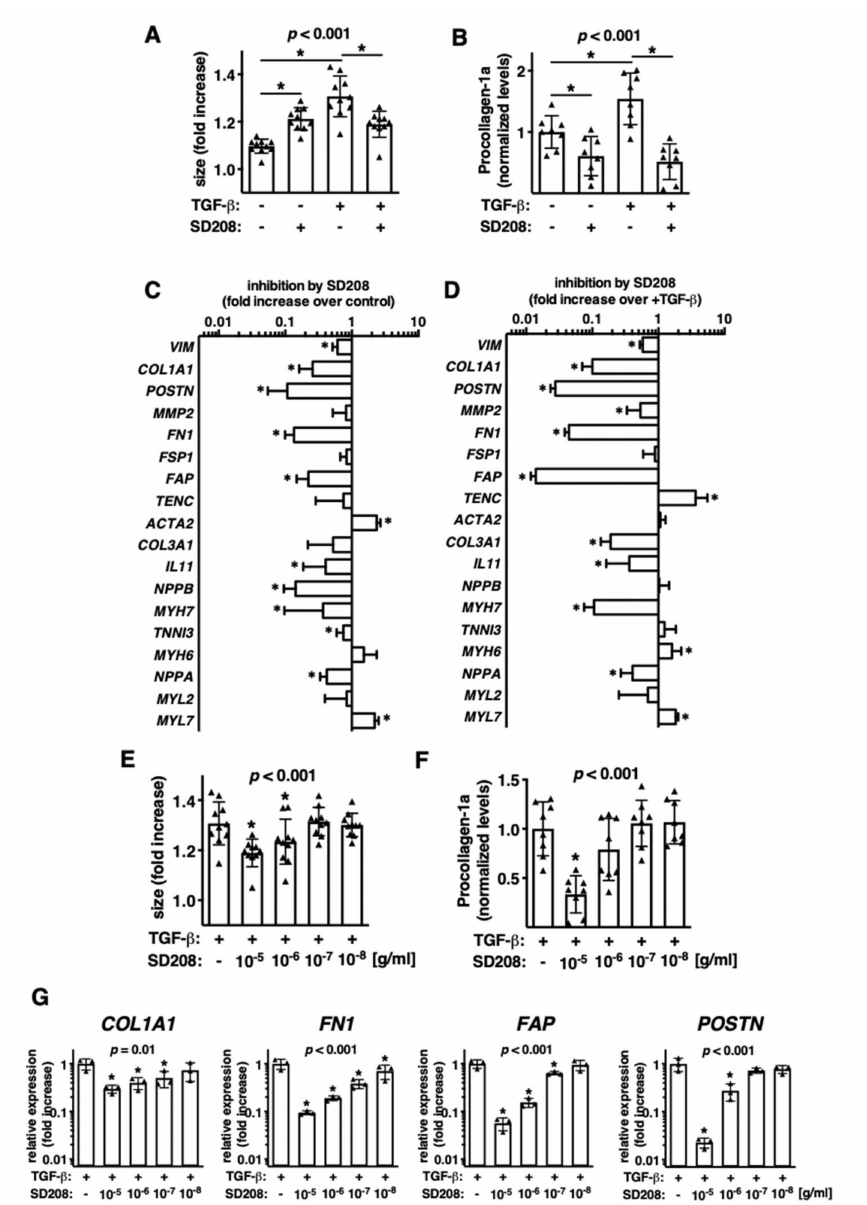
Figure 4. Pharmacological targeting of microtissues with TGF- β R1 inhibitor SD208. ( A – D ) iCMs:fCFs microtissues were cultured in the presence or absence of TGF- β 1 (10 ng / mL) and SD208 (10 µ g / mL). Panel ( A ) shows changes in size of microtissues and panel ( B ) normalized levels of secreted procollagen I (measured by ELISA in supernatants) at the indicated conditions at day 10. Each dot represents data for one microtissue. p values were calculated with ANOVA followed by uncorrected Fisher’s LSD tests for selected groups, * p < 0.05. Panels ( C , D ) show changes in gene expression in response to treatment with SD208 of microtissues cultured in the absence ( C ) or presence ( D ) of TGF- β 1. n = 6, p values were calculated with the Student’s t -test, * p < 0.05. ( E – G ) iCMs:fCFs microtissues were cultured in the presence of TGF- β 1 (10 ng / mL) and serial dilutions of SD208. Panel ( E ) shows changes in microtissue size, panel ( F ) normalized levels of secreted procollagen I and panel ( G ) relative expression of selected genes at the indicated conditions at day 10. Each dot represents data for one microtissue. Each triangle represents data for one microtissue. p values were calculated with ANOVA followed by uncorrected Fisher’s LSD tests versus + TGF- β group, * p <